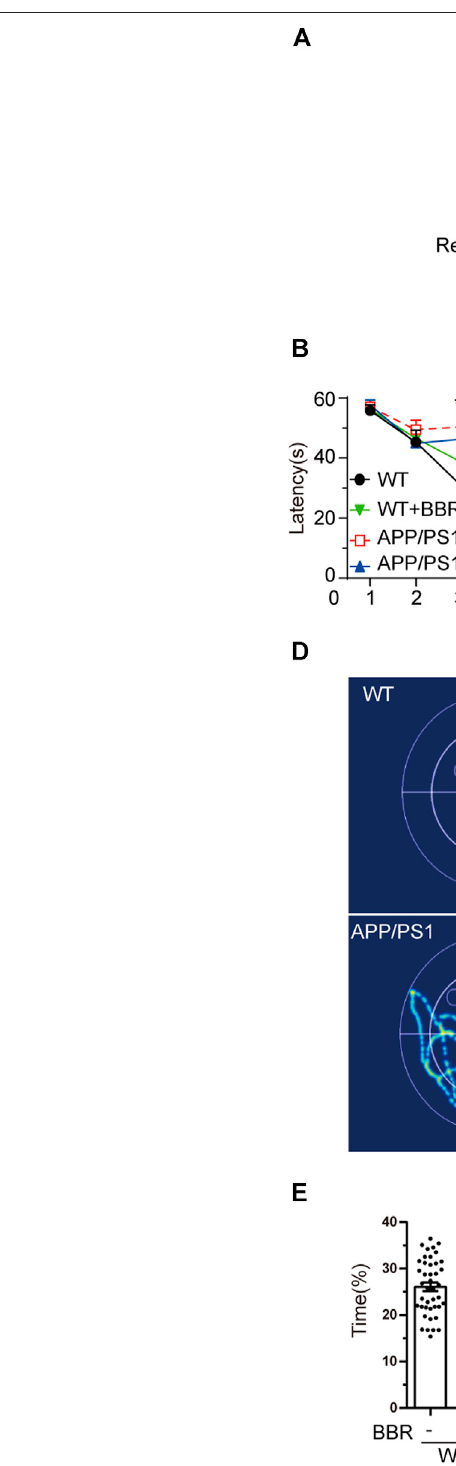
Frontiers in Pharmacology |